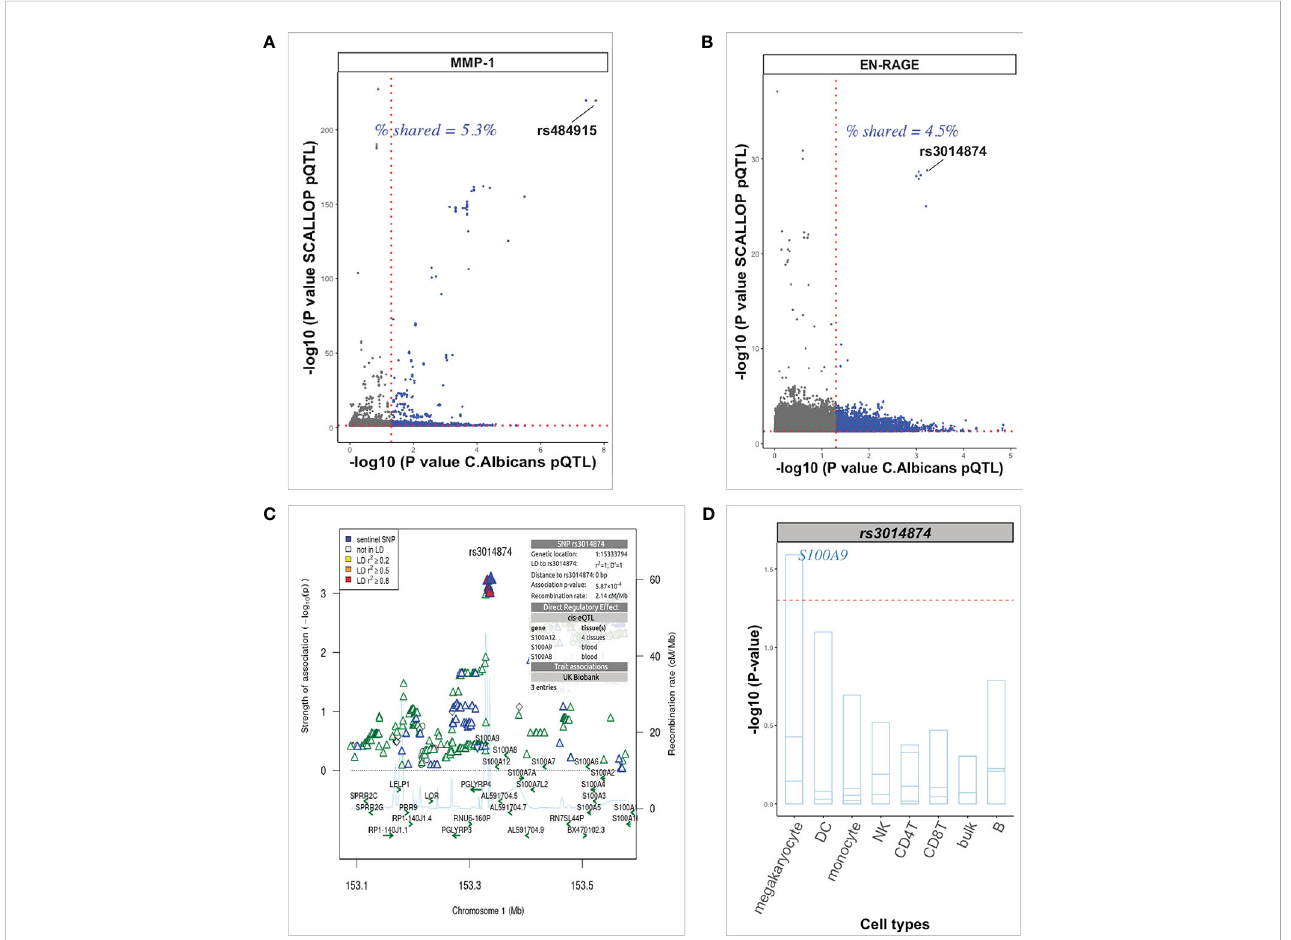
FIGURE 6 Exploration of pQTL variants in plasma from unstimulated samples. (A, B) Scatter plots generated with the “ ggbarplot ” function of pQTLs from unstimulated protein levels (SCALLOP) against candida-induced protein levels showing the proportion of shared pQTLs. Top cis-acting pQTL and trans- acting pQTL are labeled respectively. Dot gray color represents unique pQTLs from the SCALLOP data analysis without stimulation and dot blue color represents the number of overlapping pQTLs irrespective of stimulation status. (C) Regional association plot at the S100A9 locus using EN-RAGE pQTL association results after candida stimulation. The top SNP rs3014874 on chromosome 1, with direct regulatory effect on multiple cis-genes is indicated in blue diamond shape. (D) Barplot of the top trans-acting pQTL (rs3014874) association on multiple cis-genes (strips in the barplot) in the S100A9 locus in various cell types (horizontal axis). At nominal level (red dashed horizontal line), SNP rs3014874 signi fi cantly affect only S100A9 gene in megakaryocyte.